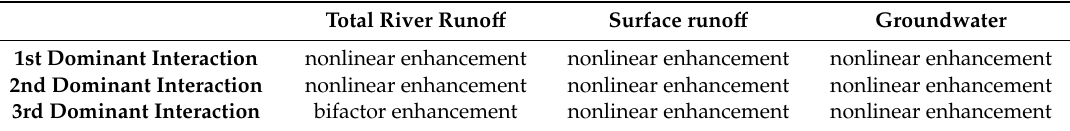
Table 11. Interaction modes of the factors on runo ff in the middle relief mountain